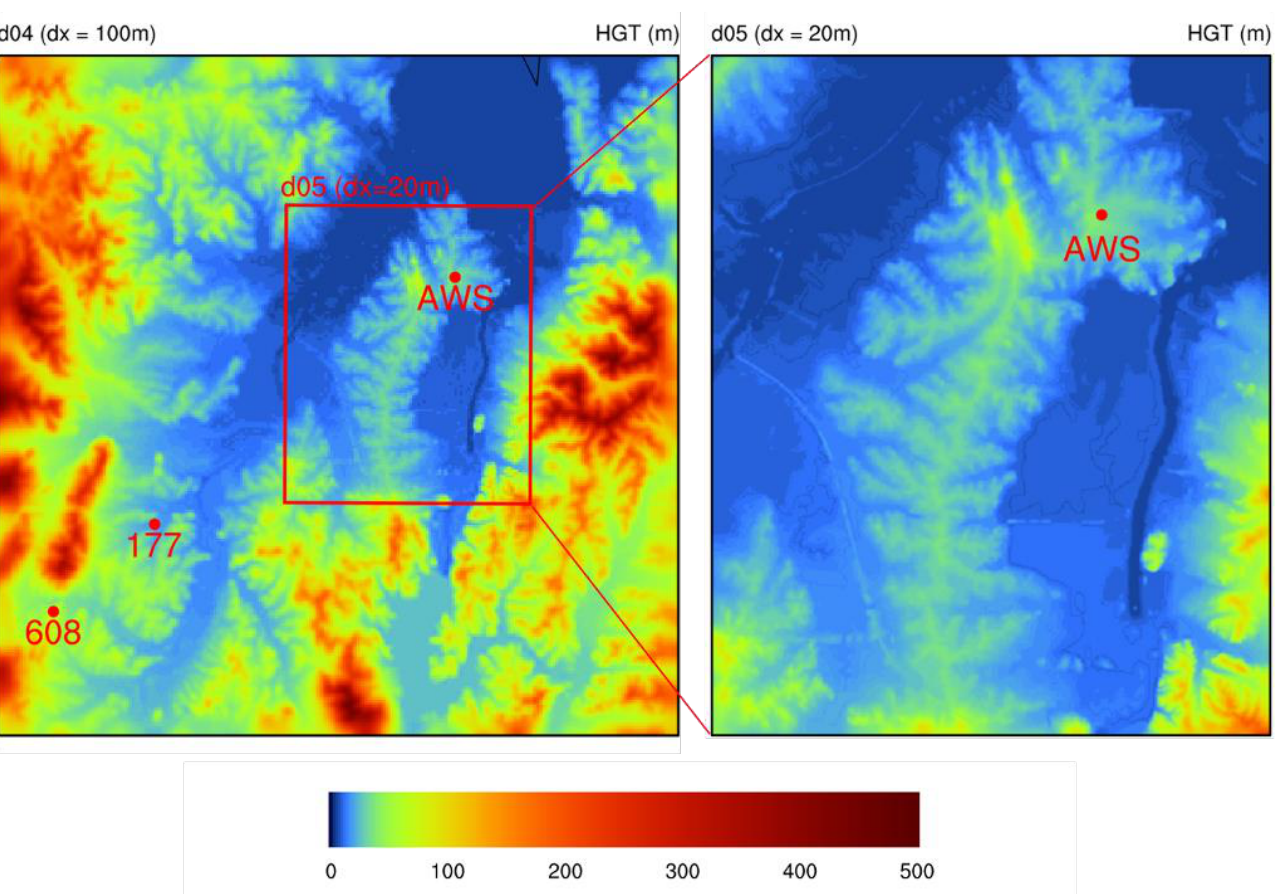
Figure 7. High-resolution terrain height (m) data and AWS sites at domain 4 and domain 5.